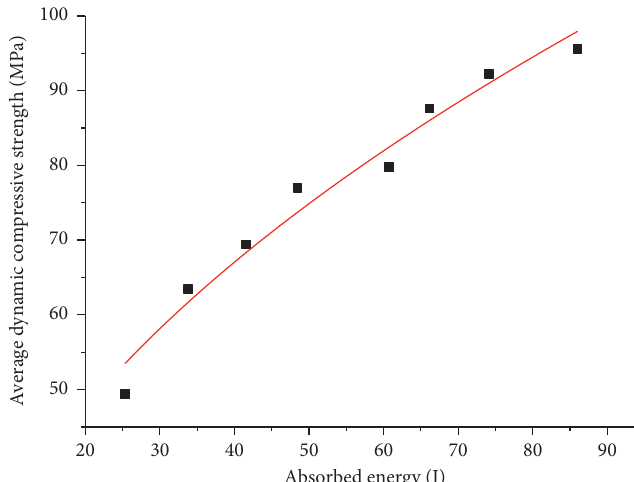
Figure 17: Relationship curve between dynamic compressive strength and absorbed